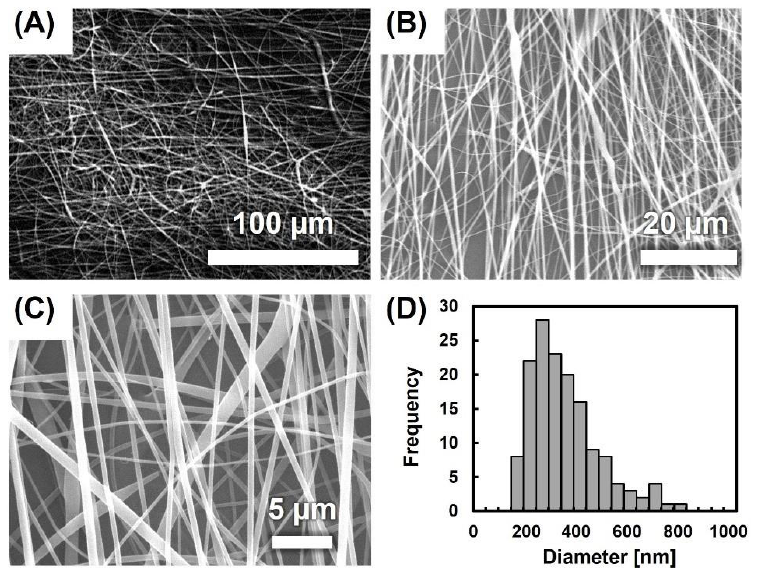
Figure 1. ( A – C ) Morphological analysis of CA/PVA + PA NF by SEM. ( D ) Distribution of the fiber diameters.